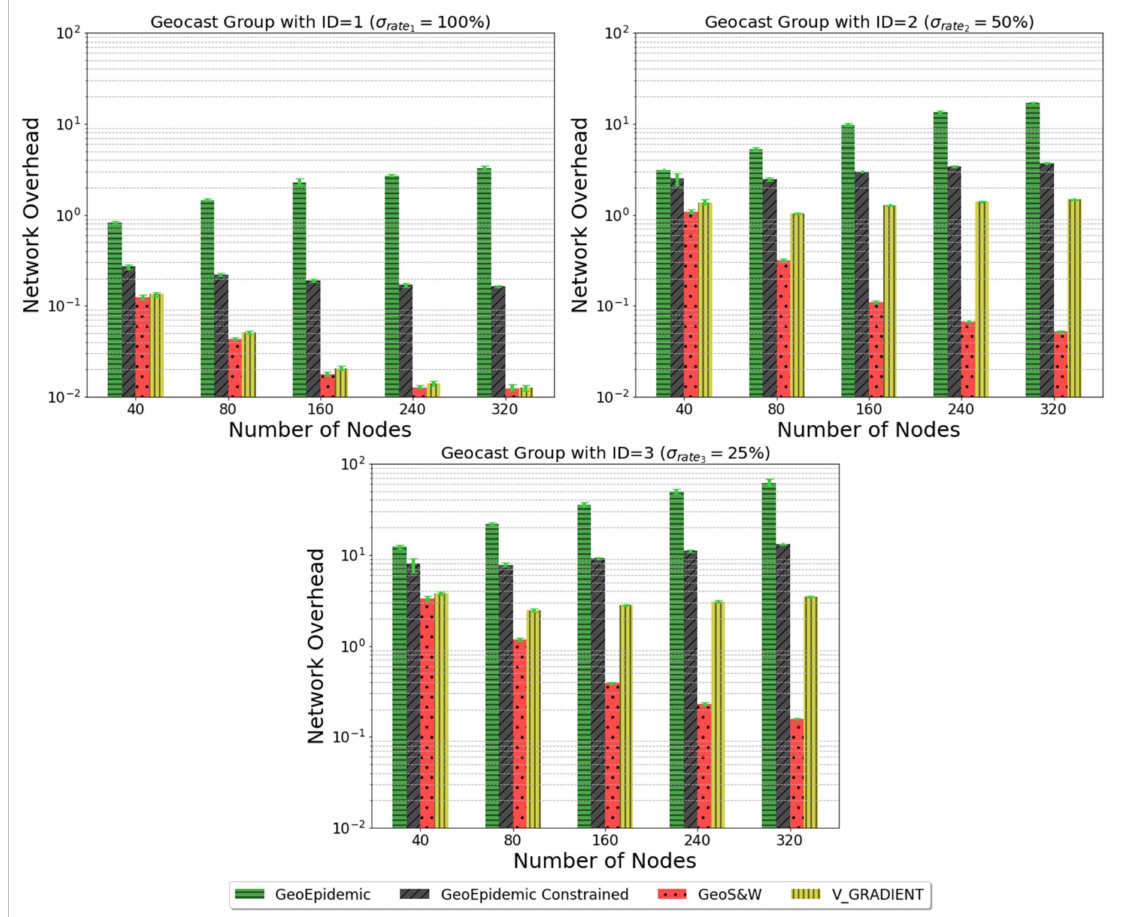
Figure 9. Overhead as a function of node density, protocol, and geocast